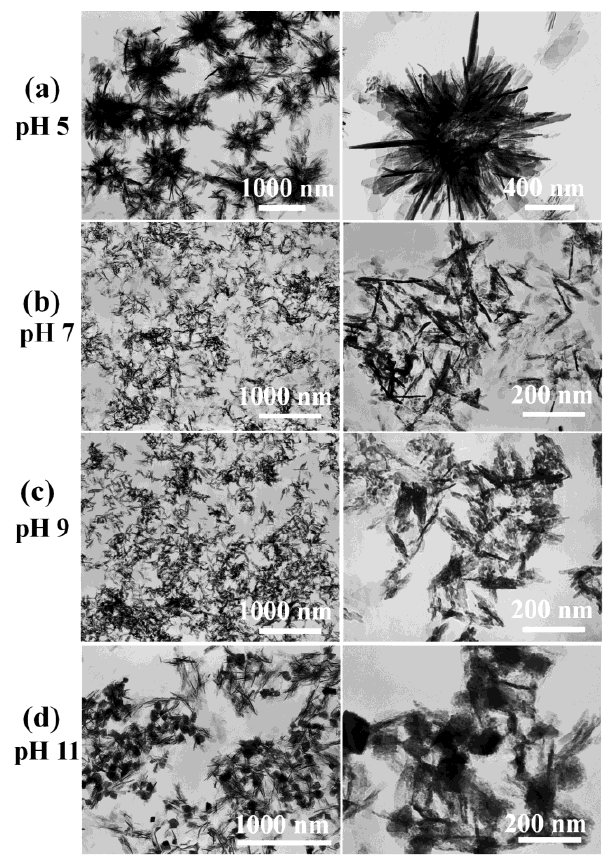
Figure 1. SEM of calcium phosphate nanostructures prepared with the microwave-assisted hydrothermal method under different pH values: ( a ) Sample A, pH = 5; ( b ) Sample B, pH = 7; ( c ) Sample C, pH = 9; ( d ) Sample D, pH =